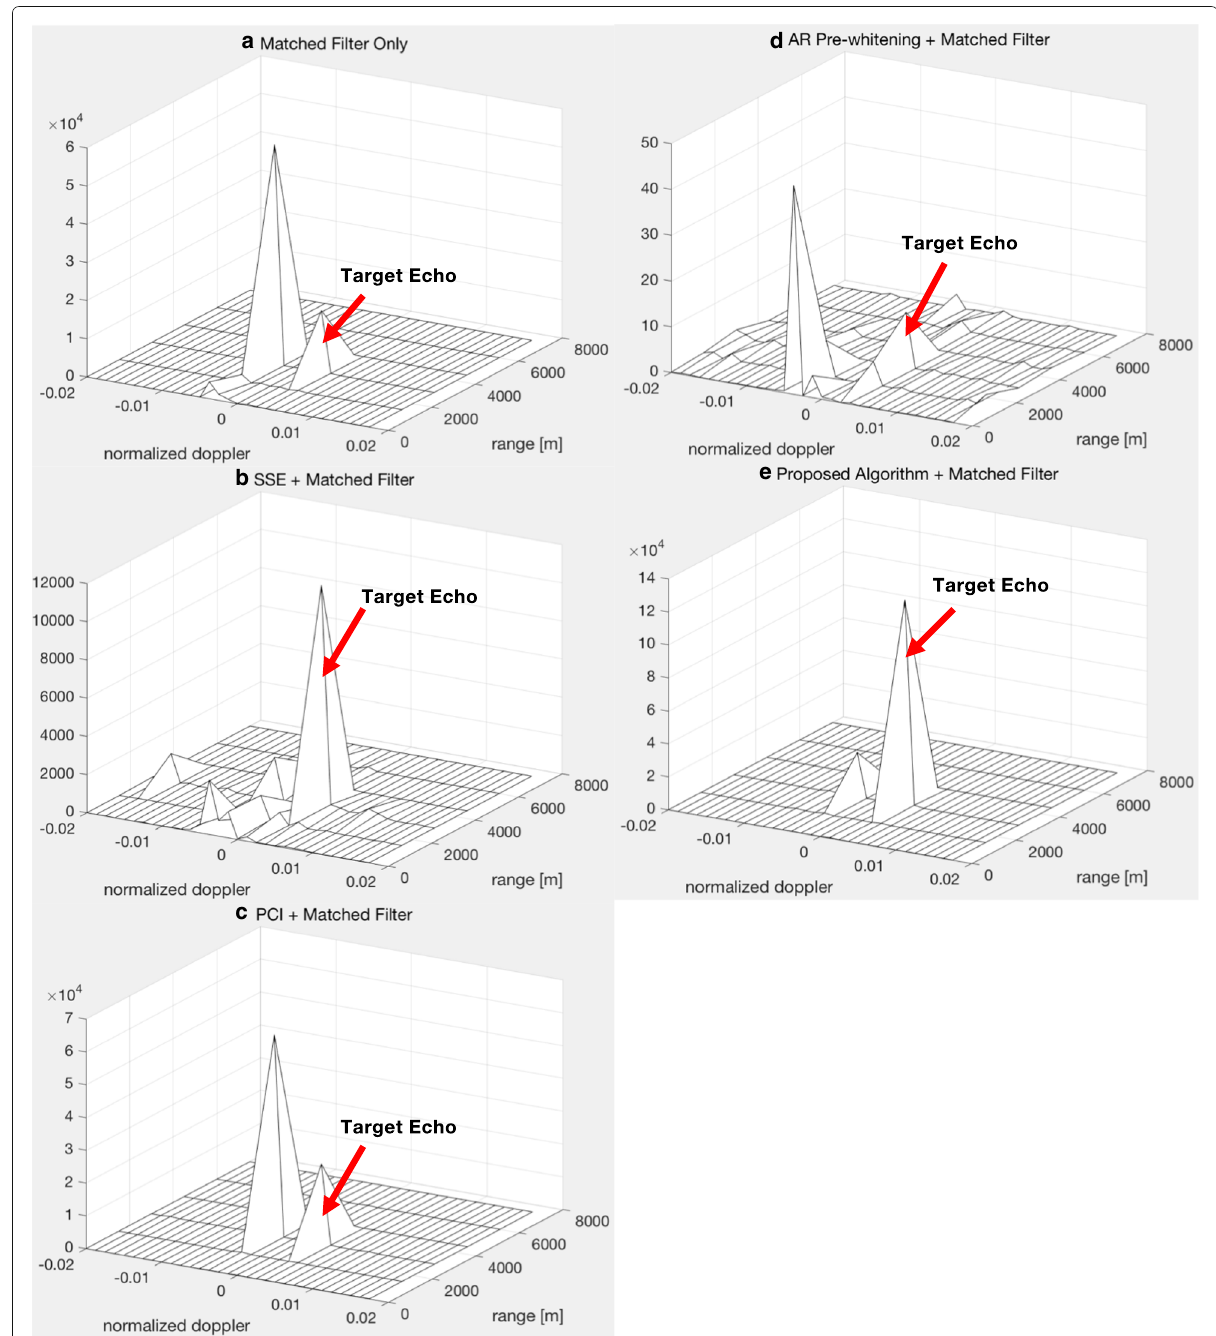
Fig. 15 Range-Doppler maps from measurement experiments. Maps of a received signal, b output signal of the SSE algorithm, c output signal of the PCI algorithm, d output signal of the AR pre-whitening, and e output signal of the proposed algorithm that is determined using a block-normalized matched